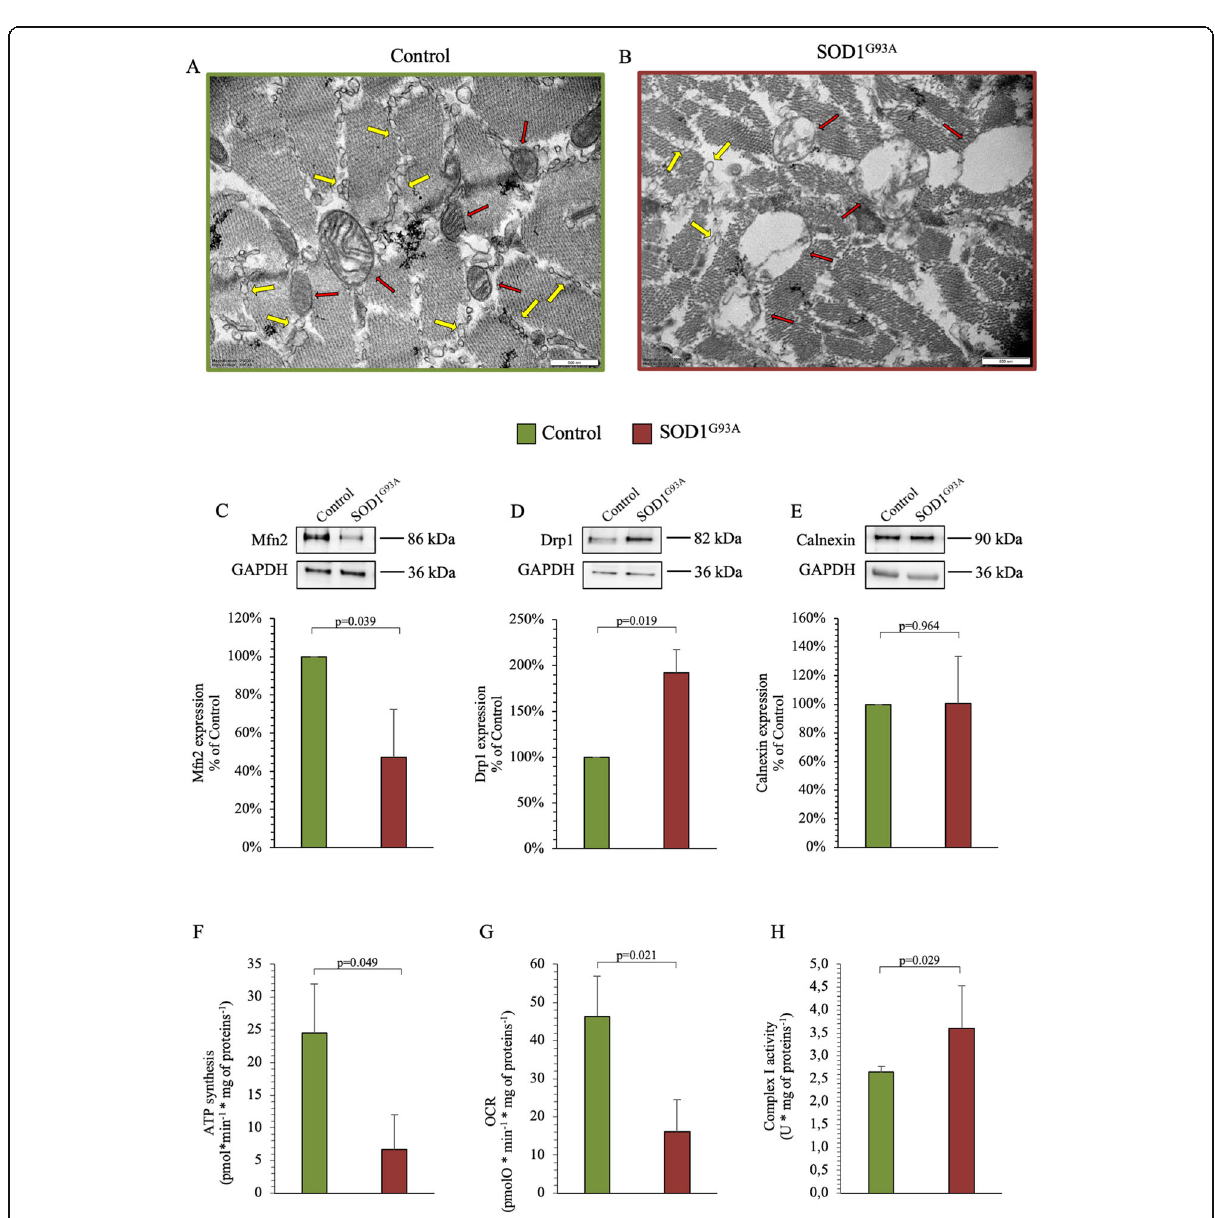
Fig. 5 Mitochondrial/ER ultrastructure and bioenergetics activity in skeletal muscles. a , b Electron microscopy representative images of control and SOD1 G93A quadriceps ( n = 3). In both panels, red arrows show mitochondria while yellow arrows show ER ultrastructural profiles. c – e Western blot analysis and relative densitometry quantitative analyses of Mfn2, Drp1, and Calnexin in the two groups. f , g ATP synthesis and oxygen consumption rate stimulated by pyruvate/malate in control (green column) and SOD1 G93A (red column) of isolated mitochondria. h Complex I activity in isolated mitochondria form control (green column) and SOD1 G93A muscles (red column) studied by the FeCN reduction in the presence of NADH. Data are expressed as mean ± SD, n = 3 for each group. Student t test for unpaired data was used for statistical